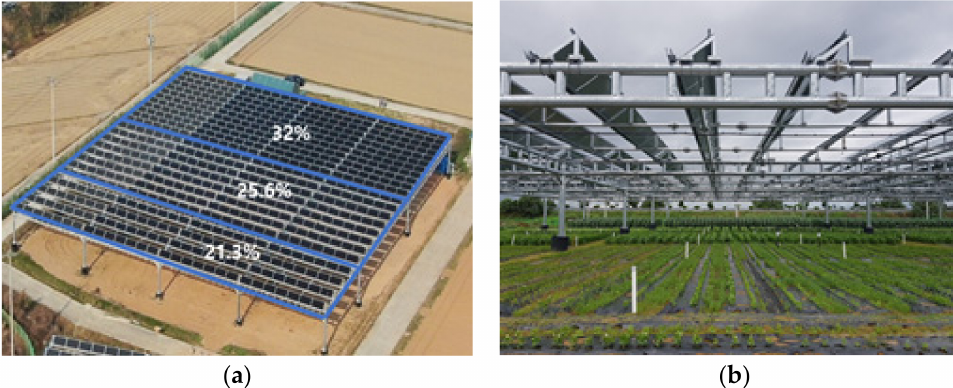
Figure 1. Overview of the subject APV system: ( a ) Solar modules with three different shading ratios; ( b ) Crop production under the subject APV system. APV: